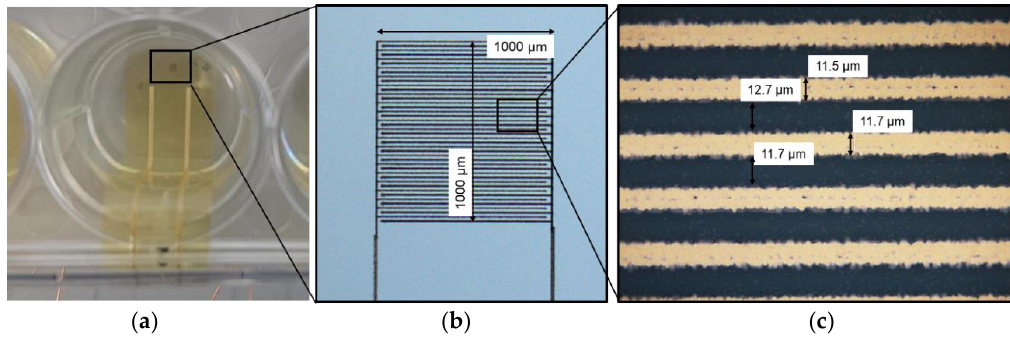
Figure 1. ( a ) Top view of the printed gold electrode (square) on flexible polyimide within the well of a standard 12-well cell culture plate; ( b ) microscopic view of the uncovered gold interdigital electrode with a printed thickness of approx. 300 nm; ( c ) line width and line space of the electrode fingers.